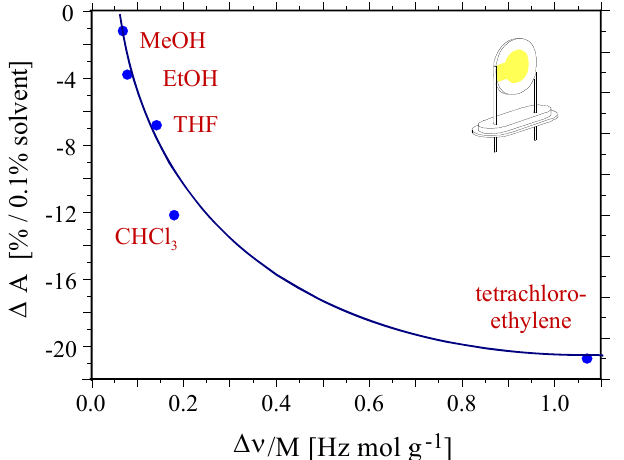
Figure 4. Optical absorbance changes versus relative QCM response for different analyte